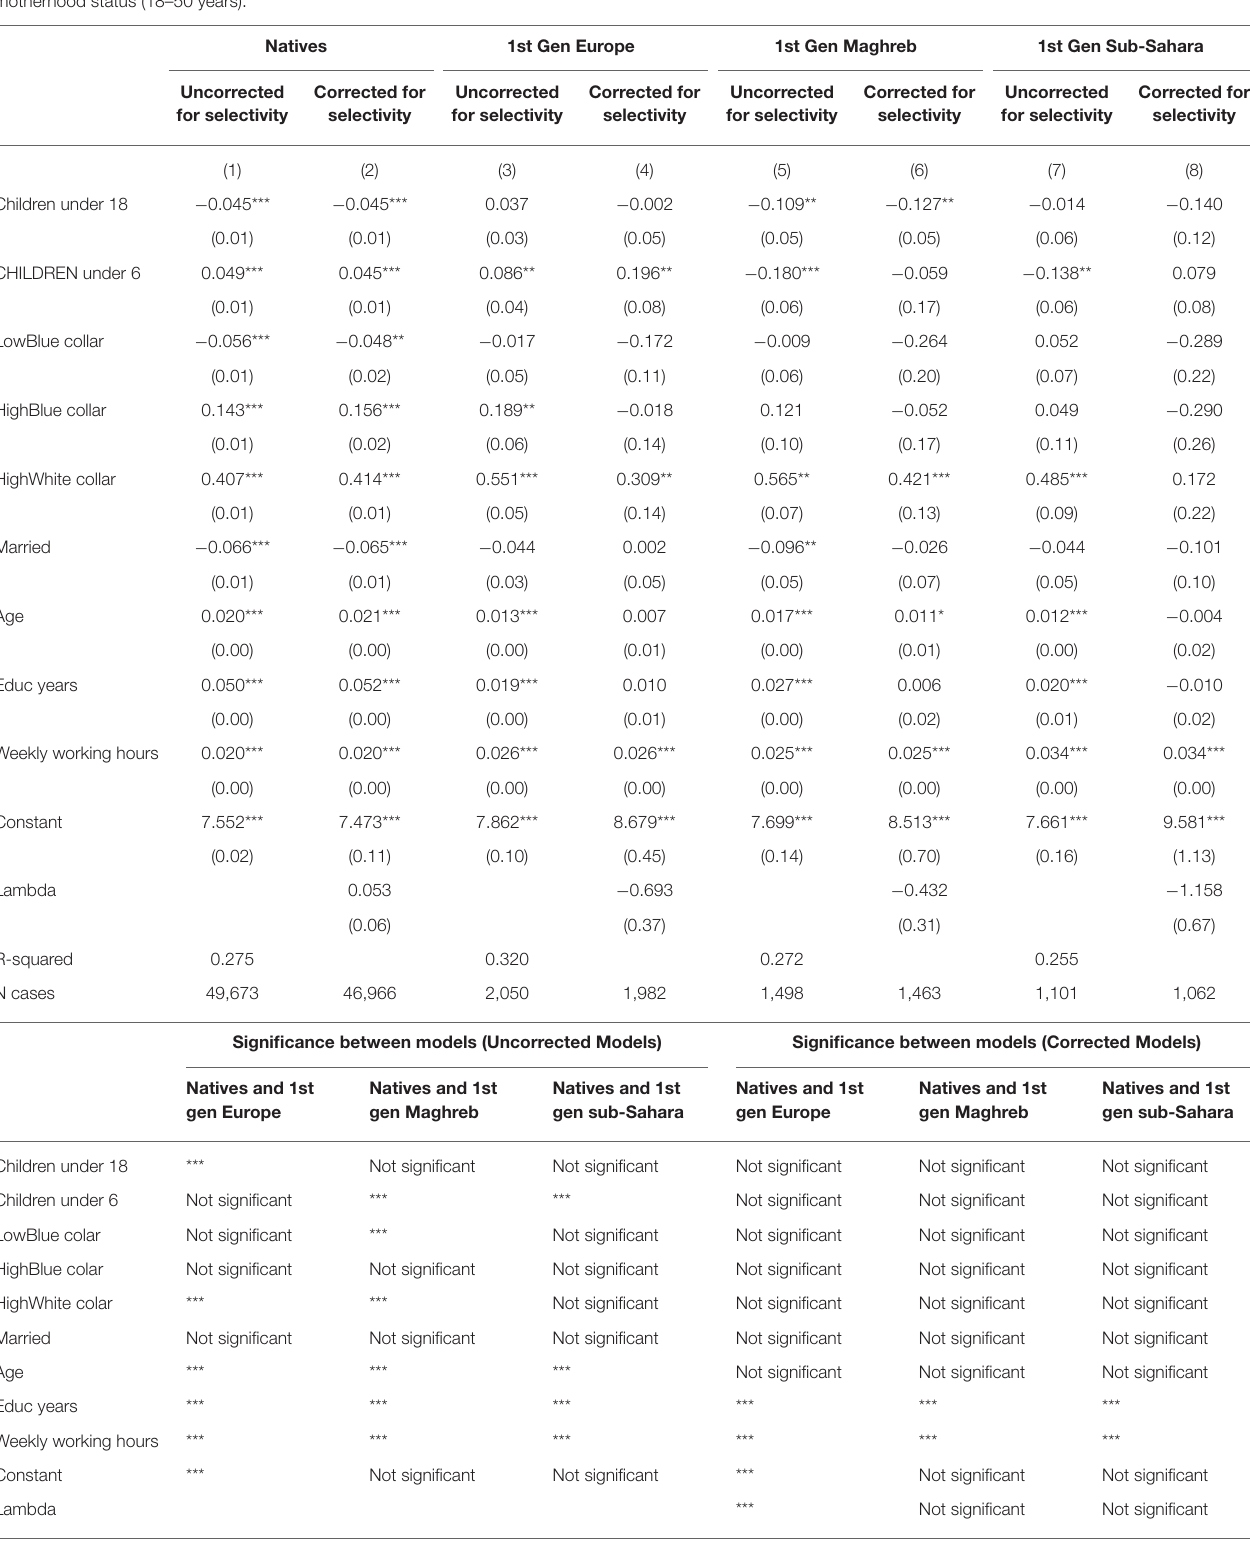
TABLE 4 | Linear Regression predicting the logarithmic transformation of the yearly income of women in the French labor market according to the region of origin and motherhood status (18–50 years). Natives 1st Gen Europe 1st Gen Maghreb 1st Gen Sub-Sahara Uncorrected Corrected for Uncorrected Corrected for Uncorrected Corrected for Uncorrected Corrected for for selectivity selectivity for selectivity selectivity for selectivity selectivity for selectivity selectivity